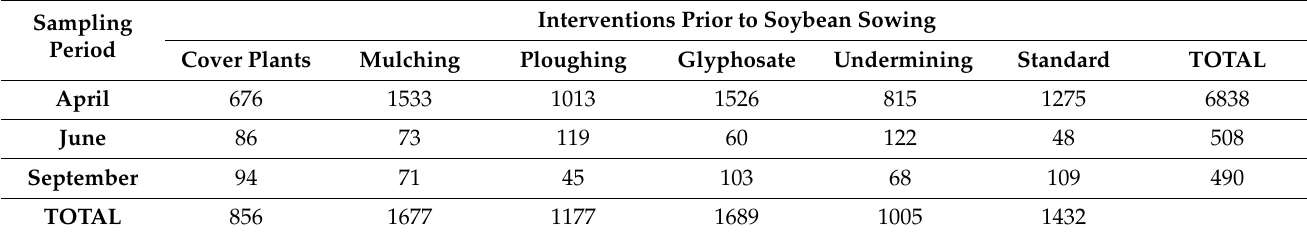
Table 4. Abundance of the total soil-dwelling fauna in all variants during investigation